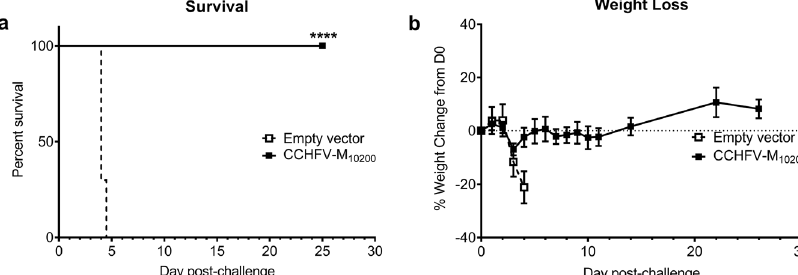
Fig. 1 CCHFV-M 10200 DNA vaccination completely protects against homologous challenge. Groups of 10 C57BL/6 mice were vaccinated with 50 μ g CCHFV-M 10200 or empty vector on days 0, 21, and 42 by IM-EP. a Group survival and ( b ) weight change of CCHFV-M 10200 vaccinated mice following CCHFV challenge with 100 PFU by the IP route with the homologous CCHFV-IbAr 10200 strain. Vaccinated C57BL/6 mice were transiently immunosuppressed prior to challenge. **** p < 0.0001. The percent survival p value was determined by a log rank test.